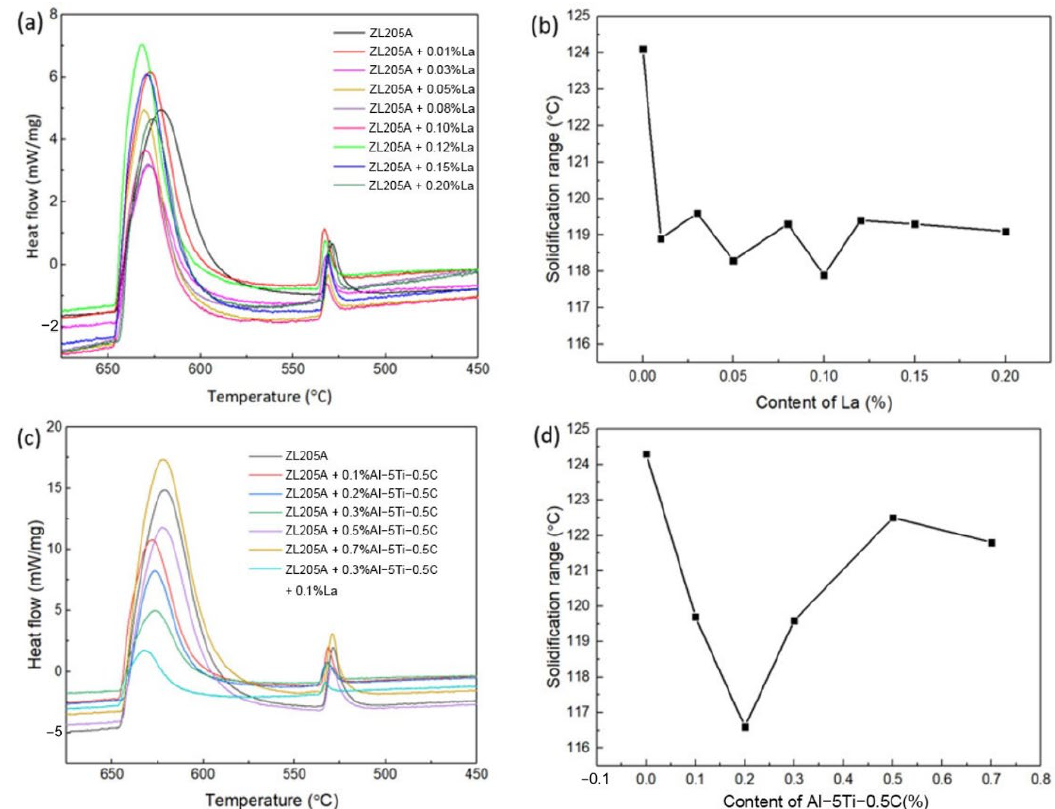
Figure 7. DSC cooling curves and solidification range of ZL205A alloy with different levels of ( a , b ) La and ( c , d ) Al−Ti−C .